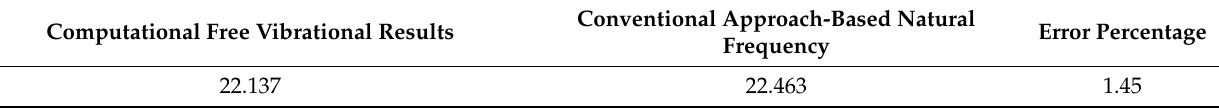
Table 2. Validation of Modal Analysis (Natural frequency) (Hz).